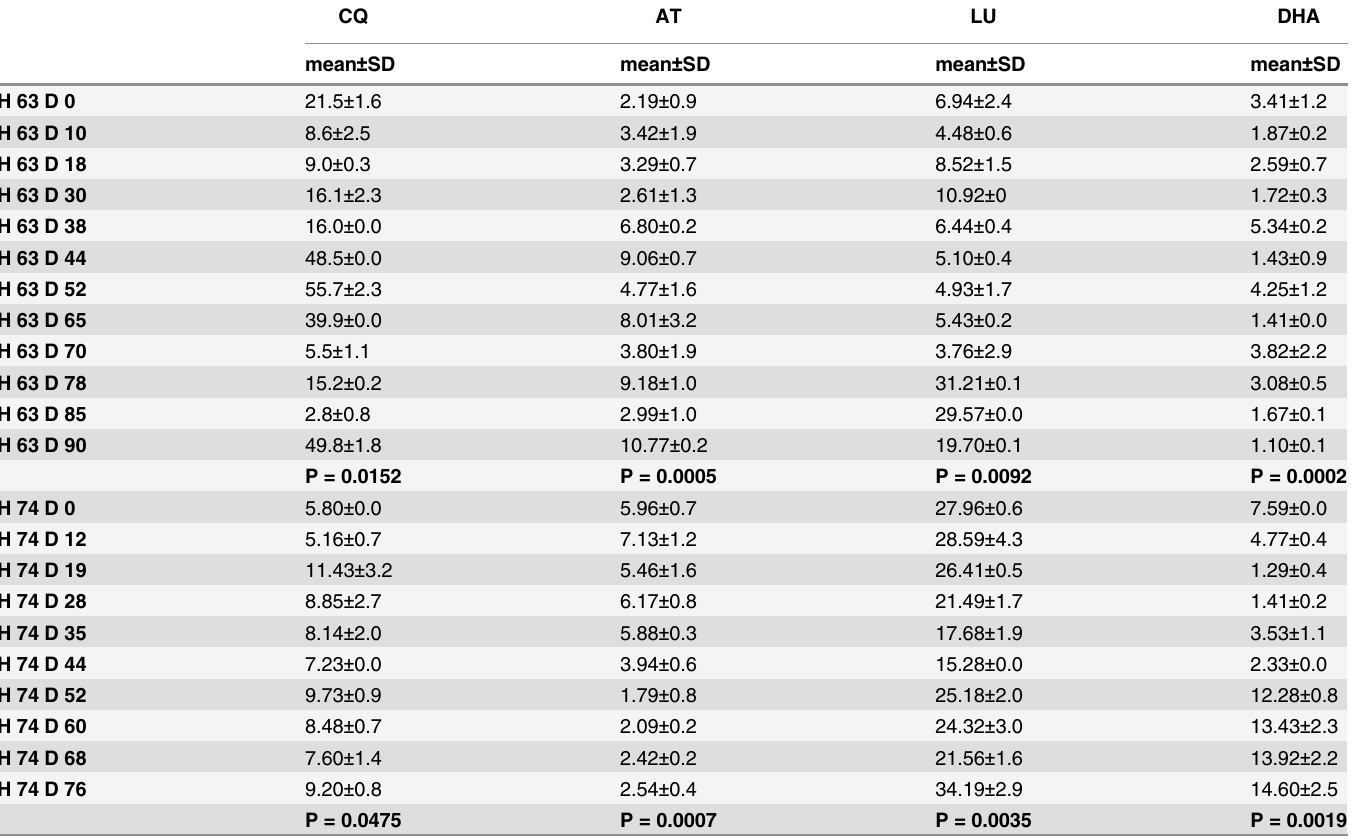
Table 2. IC 50 s for select antimalarials. Values represent means and standard deviations for each assay run in four-replicates. For each parasite-line and each drug tested, p value is shown. ND = No Data.